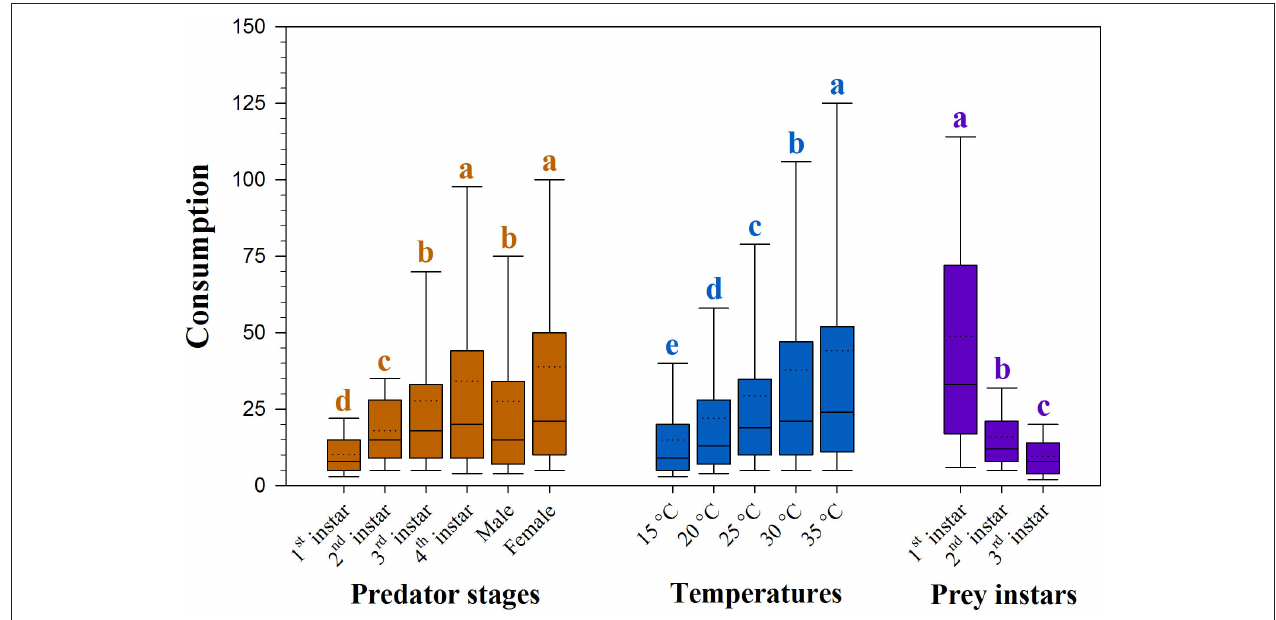
FIGURE 1 | Consumption of prey Spodoptera litura by Harmonia axyridis at five temperatures and three prey instars. Box plots show the range of data (lower and upper quartiles), median (line), and mean (dotted line), and different lowercase letters above the whisker caps indicate significant differences among group mean values according to 95% CI. Number of replications (N) =